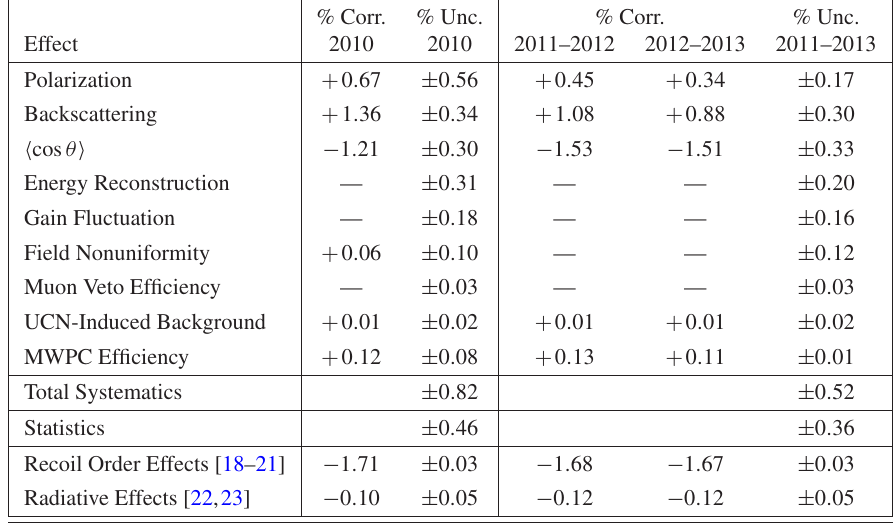
Table 2. Summary of the systematic and statistical errors for the 2010, 2011–2012, and 2012–2013 data taking runs. Note that a + ( − ) sign correction indicates the corrections increases (decreases) the magnitude of the asymmetry. % Corr.